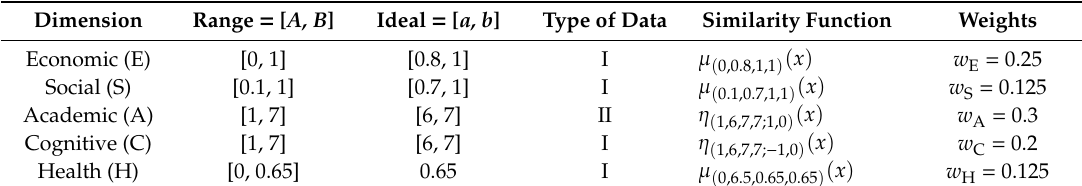
Table 4. Range, ideal, and similarity functions of each dimension.